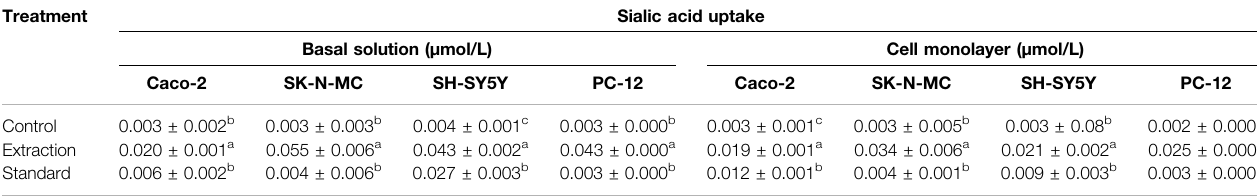
TABLE 2 | Sialic acid uptake studies by Caco-2, SK-N-MC, SH-SY5Y, and PC-12 cell lines. Treatment Sialic acid uptake